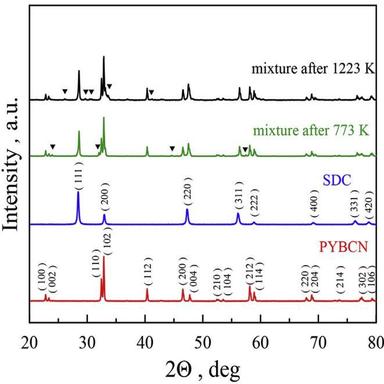
XRD patterns for individual compounds and 70/30 wt% mixture thereof after firing at 773 and 1223 K for 24 h. Impurity reflections are shown by triangles.